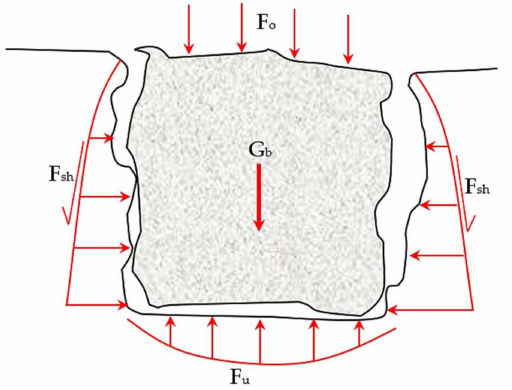
resistance of the block are the submerged weight of the block ( G b ) , the pressure on top of the block ( F o ) , and the shear resistance along the sides of the block ( F sh ) .